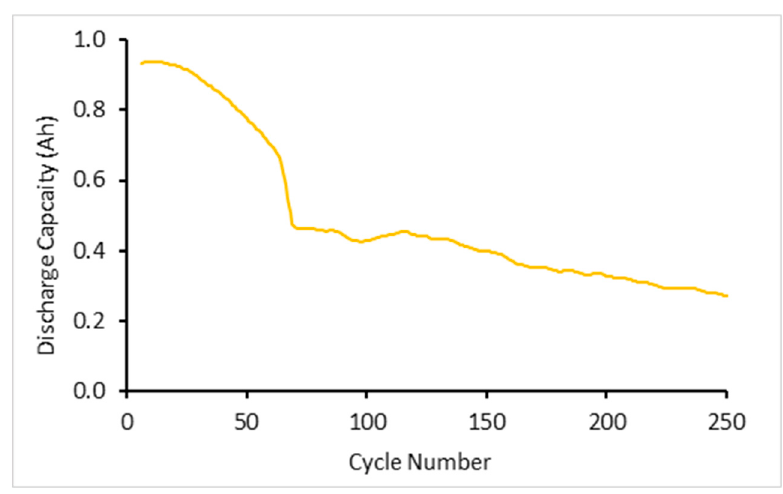
Figure 2. Average discharge capacity in high rate cycling test.